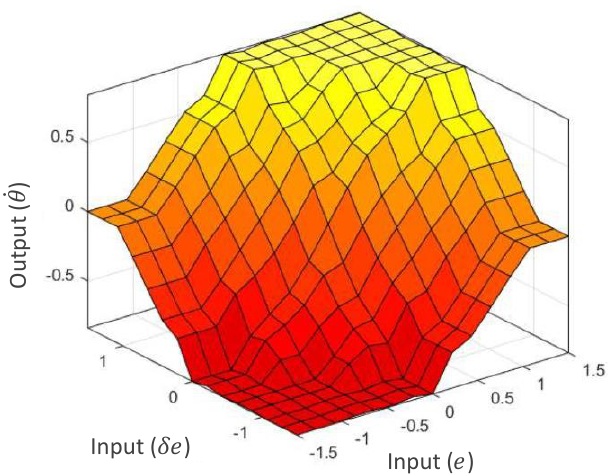
Figure 11. Decision surface of the fuzzy logic